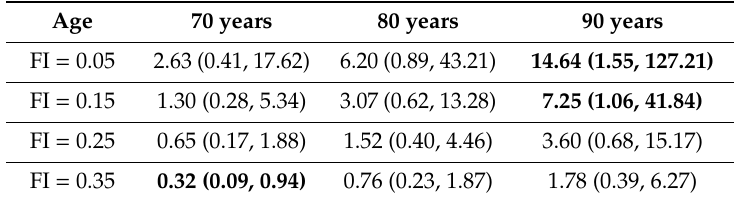
Table 4. Simple associations between social vulnerability and odds of LTC placement at di ff erent levels of frailty and ages for the main analyses: OR